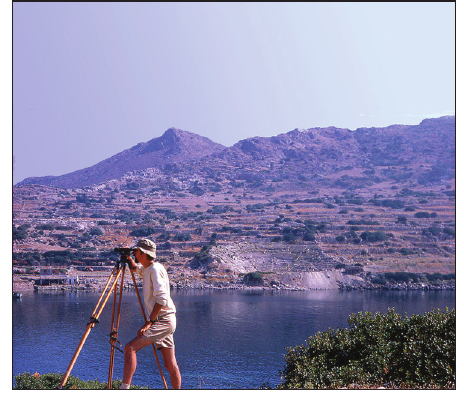
Figure 1: David Price Williams levelling at Knidos, 1969, with the mainland city in the background (Photo: David Price